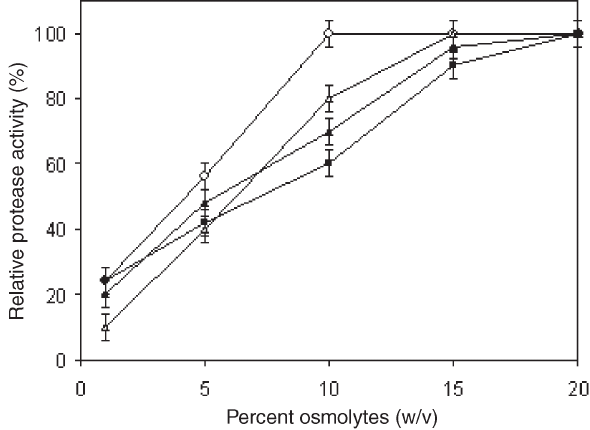
Figure 7. Effects of osmolytes on the purified protease activity in the absence of NaCl. The enzyme was incubated in the various concentra- tions of osmolytes: sucrose ( (cid:5) ); mannitol ( (cid:3) ); glycerol ( (cid:4) ); and betaine ( (cid:6) ) without NaCl in standard assay conditions. Each value represents the mean ± SE of three independent experiments.